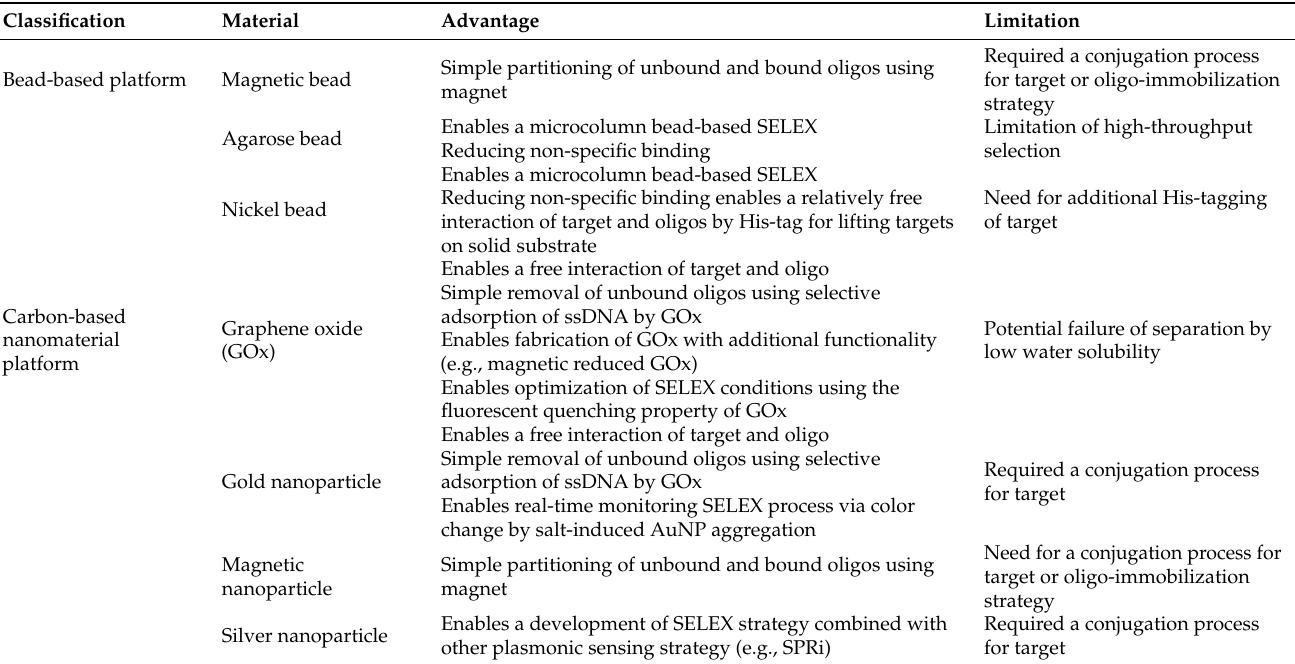
Table 3. Advantages and limitations of micro/nanomaterial-based